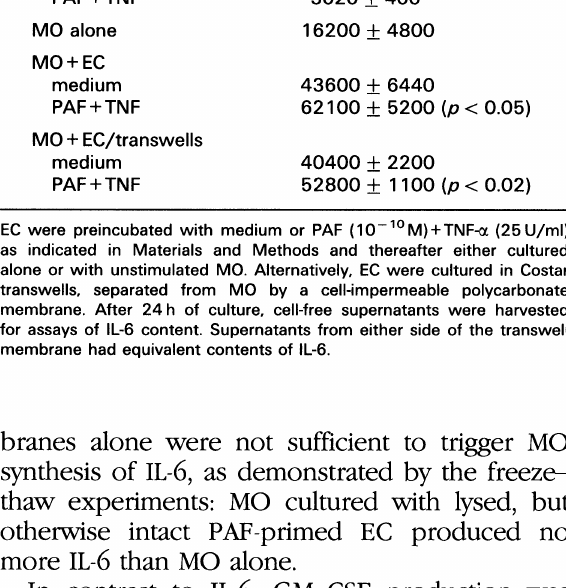
Table 1. Contact-independent synergy of EC and MO in IL-6 production Cells IL-6 (U/ml) EC alone medium 1200 PAF + TNF 3020 MO alone 16200 -t- 4800 MO + EC medium 43600 + 6440 PAF + TNF 62100 MO + EC/transwells medium 40400 PAF+TNF 52800 -t- 1100 (p< 0.02) EC were preincubated with medium or PAF (10-1M)+TNF- (25U/ml) as indicated in Materials and Methods and thereafter either cultured alone or with unstimulated MO. Alternatively, EC were cultured in Costar transwells, separated from MO by a cell-impermeable polycarbonate membrane. After 24 h of culture, cell-free supernatants were harvested for assays of IL-6 content. Supernatants from either side of the transwell membrane had equivalent contents of